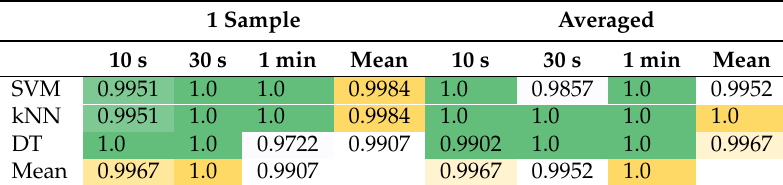
Table 6. Resolution selection results for the fitness gym location. Individual scores are shown in green and mean scores in yellow. A stronger color indicates a higher score.